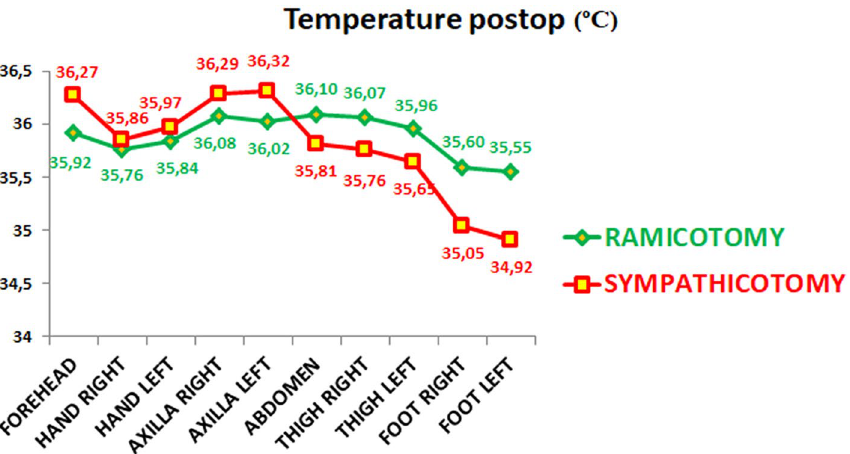
Figure 4. Postoperative temperature of the different anatomical areas. We see a more significant drop in the abdomen, thighs, and feet in the sympathicotomy group, attesting that they suffer from a more substantial